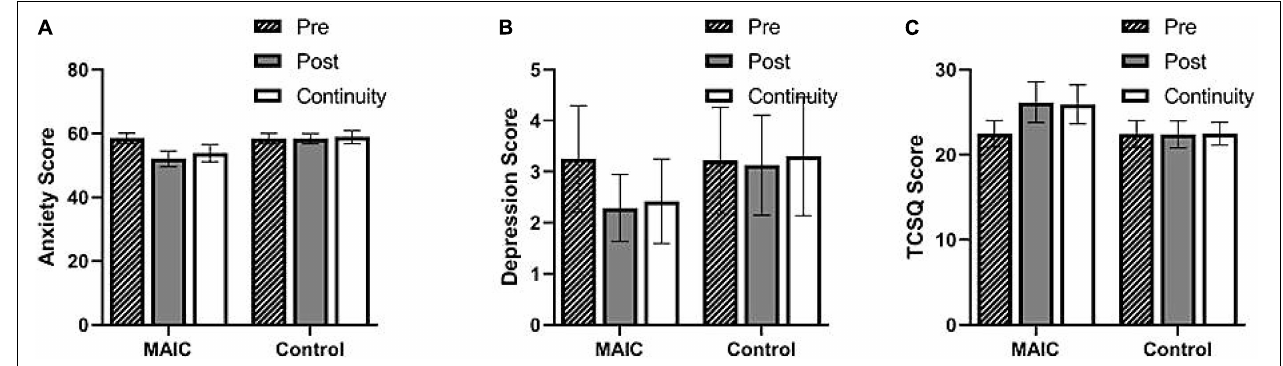
FIGURE 4 | Comparisonof mental health scores between the MAIC group and control group. (A) Comparison of training and Competition Satisfaction between MAIC group and control group. (B) Comparison of depression between MAIC group and control group. (C) Comparison of anxiety between MAIC group and control